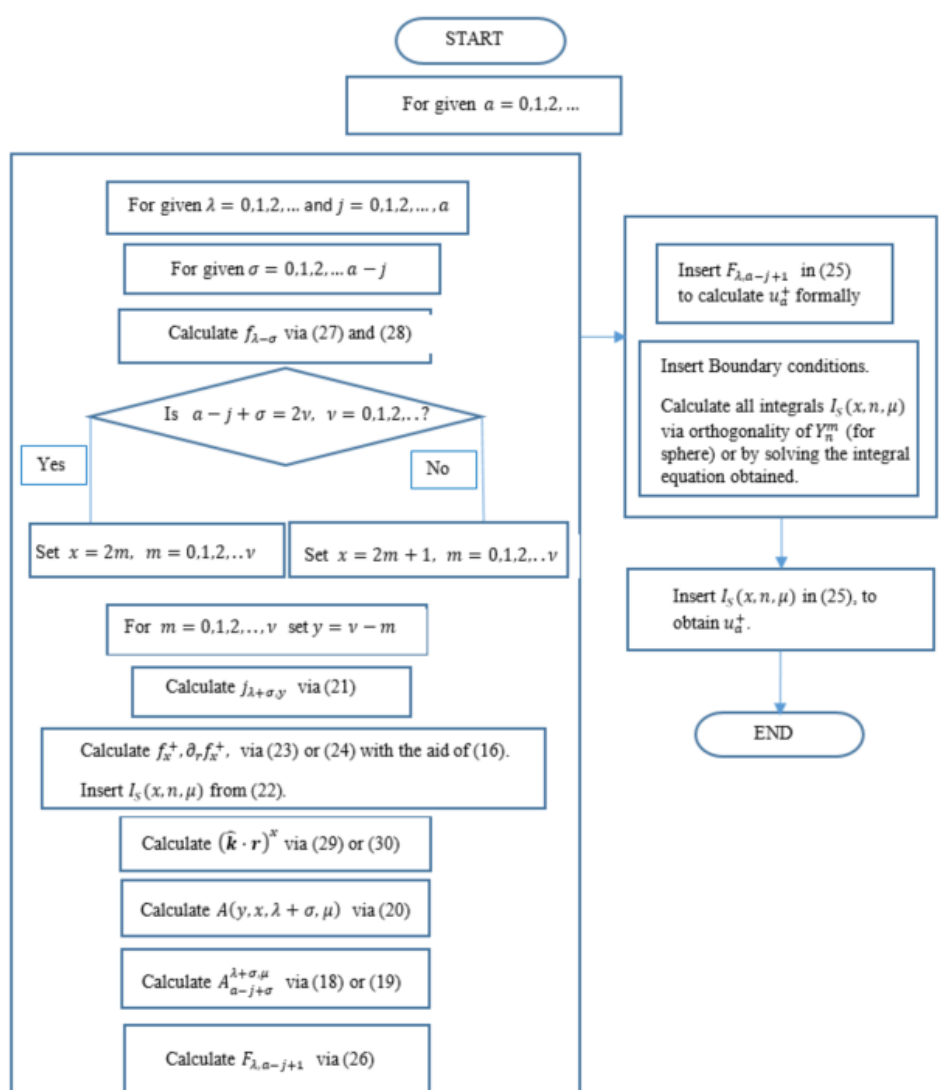
Figure 1. Algorithm for calculation of (LF) coefficients via